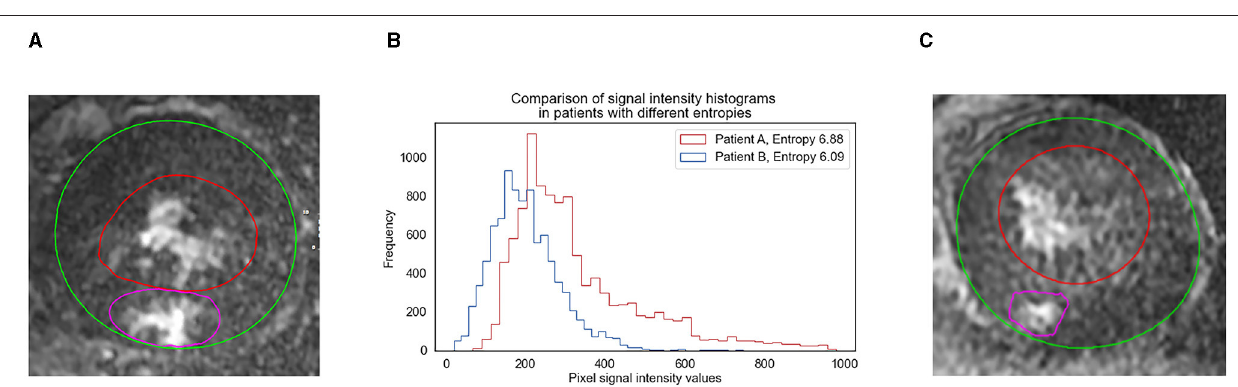
FIGURE 3 | Scar entropy model and signal intensity (SI) histograms in two HCM subjects with or without VAs. The image demonstrates the uniformity of signal intensity in the scar, with the epicardial border in green and the endocardial border in red. The area shaded in red identifies the scar detected by the full width at the 5-SD method. (A) Image from an HCM patient who experienced VA events. (C) Image from an HCM patient who experienced non-VA events. (B) The histogram (middle) shows the probability distribution of the pixel signal intensities for both patients. Note the high frequency of pixels within a narrow range of SIs for patient B (blue line), suggesting little heterogeneity of the scar tissue and this patient had scar entropy of 6.09. Note the more dispersed distribution of SIs for patient A (orange line). The patient had scar entropy of 6.88, indicating a much more heterogeneous scar. Both patients were scanned using 1.5-T